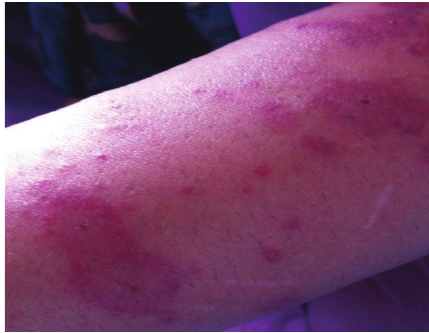
Figure 9: One week after hospitalization.